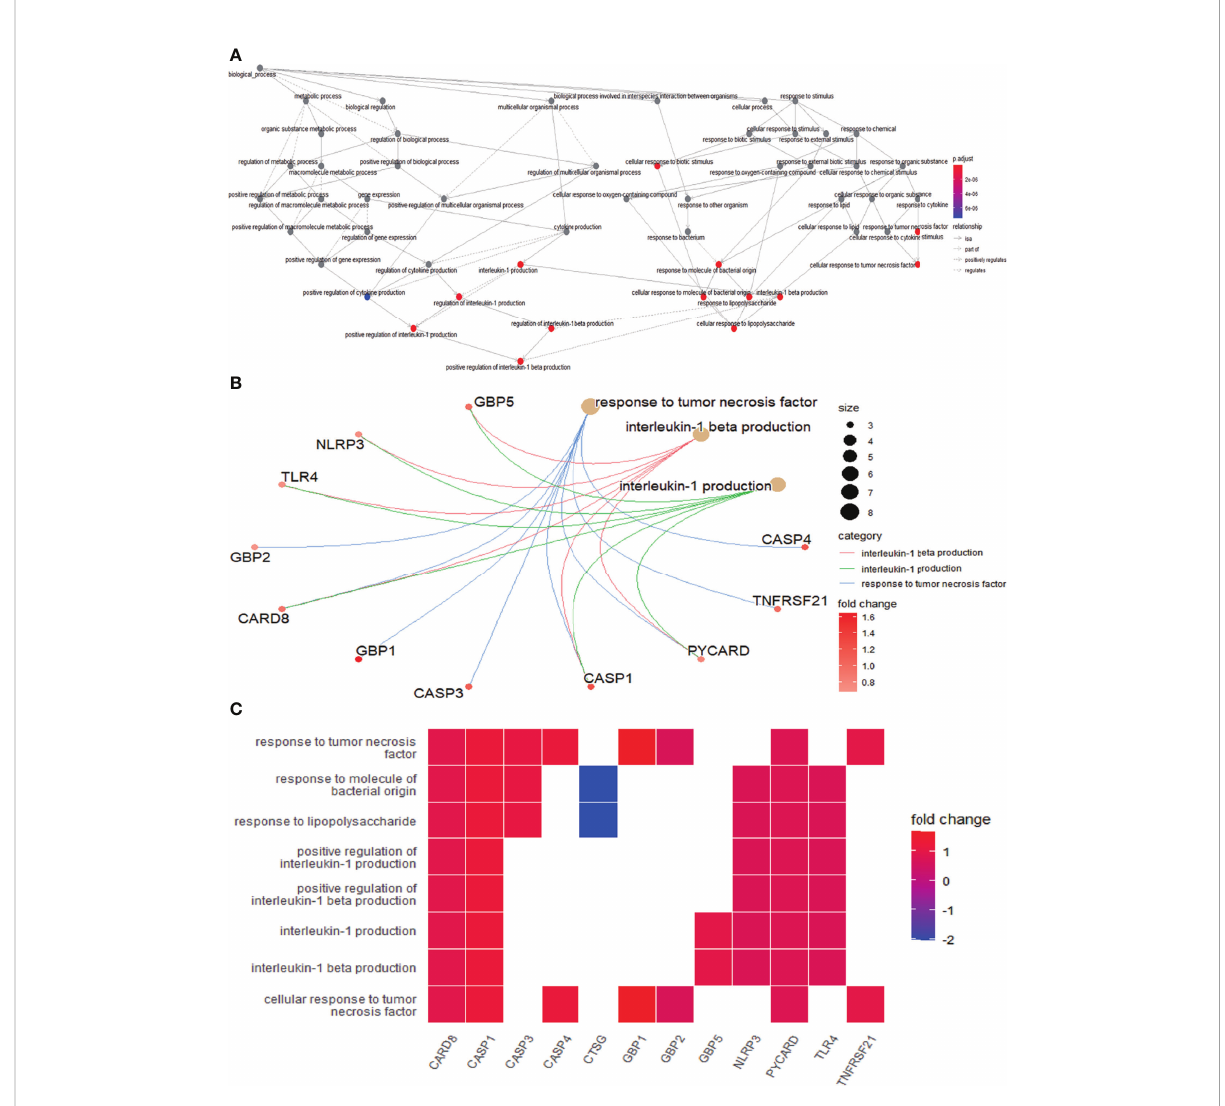
FIGURE 4 Further analysis of the results obtained by GO enrichment analysis. (A) Relationship between the pathways obtained by GO enrichment analysis. (B) Common genes among the three most prominent pathways. Each path is represented by lines of different colors. (C) Heatmap-like functional classi fi cation. The enrichment relationships of differentially expressed PRGs in the eight most signi fi cant pathways are shown. GO, Gene Ontology; PRGs, pyroptosis-related